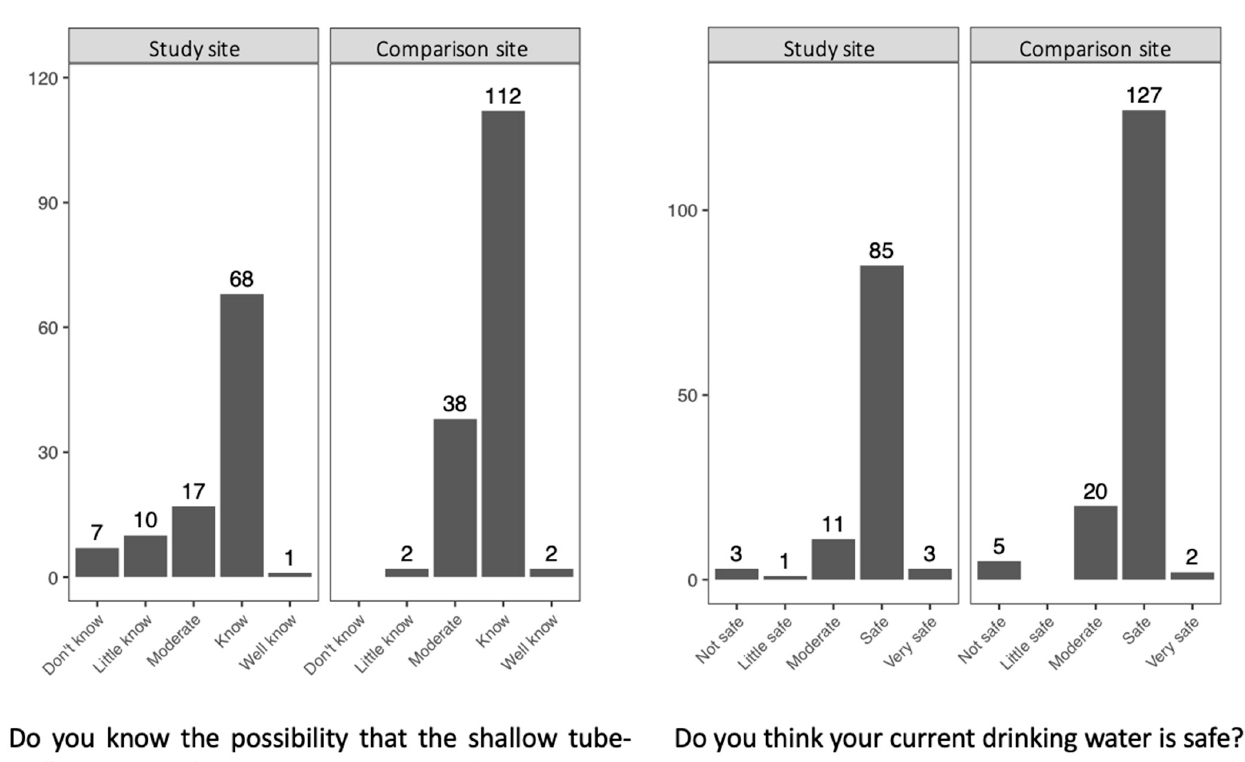
Figure 3. Comparison of villagers’ perceptions of As-related risk. The answers in the left figure show the degree of knowledge. Little know was recorded when a respondent had information but did not seem to understand it and hesitated to answer Don’t know . Moderate was recorded when a respondent had information and understood it but did not seem to believe it and made confusing statements. Know was recorded when a respondent had information and understood it. Well know was recorded when a respondent had information and was able to explained it well.